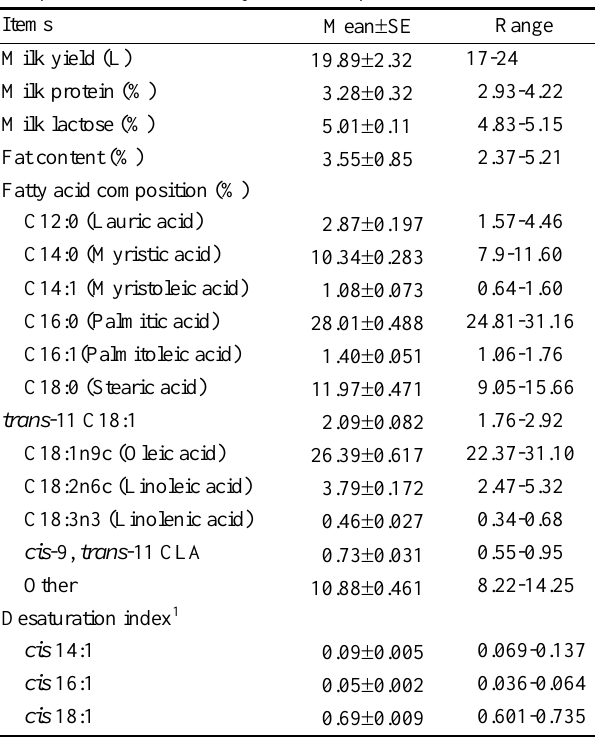
Table 5. Important parameters and major milk fatty acids composition (%) from dairy cows in Experiment 2 Items Mean  SE Range